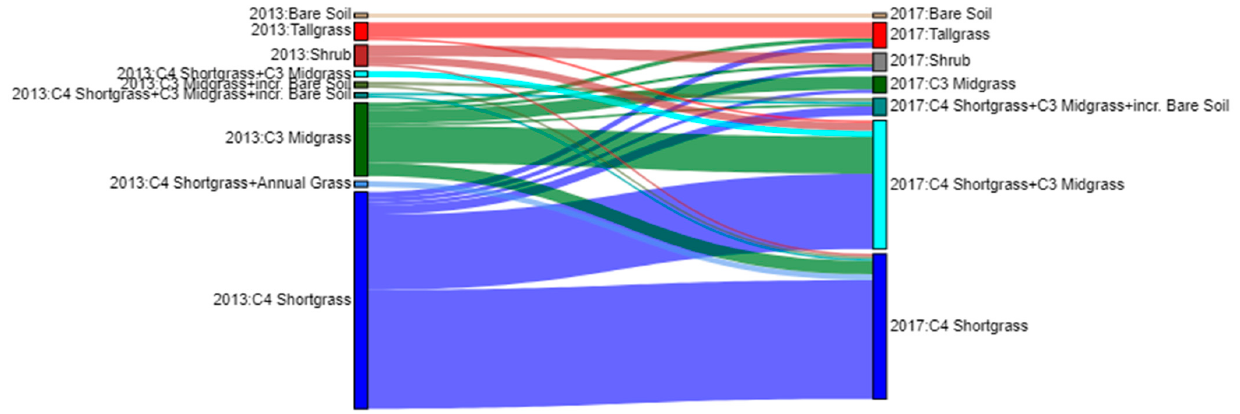
Figure 7. Sankey plot detailing the change in plant communities from 2013 to 2017. For clarity, plant community classes that accounted for less the 0.5% of the change were excluded from this plot.